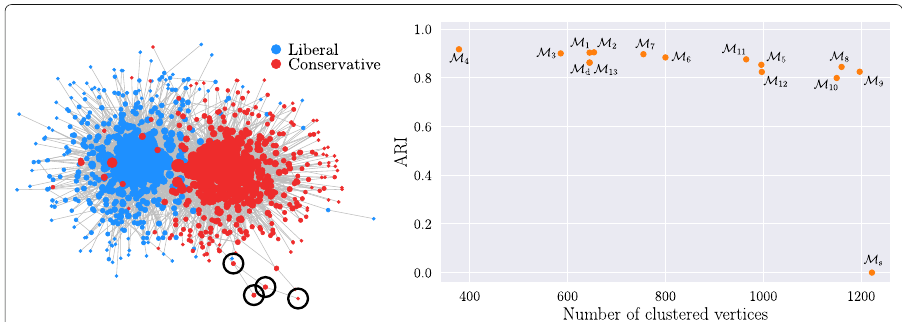
Fig. 13 Left: the US-P OLITICAL -B LOGS network. Right: ARI score against number of clustered vertices, across various